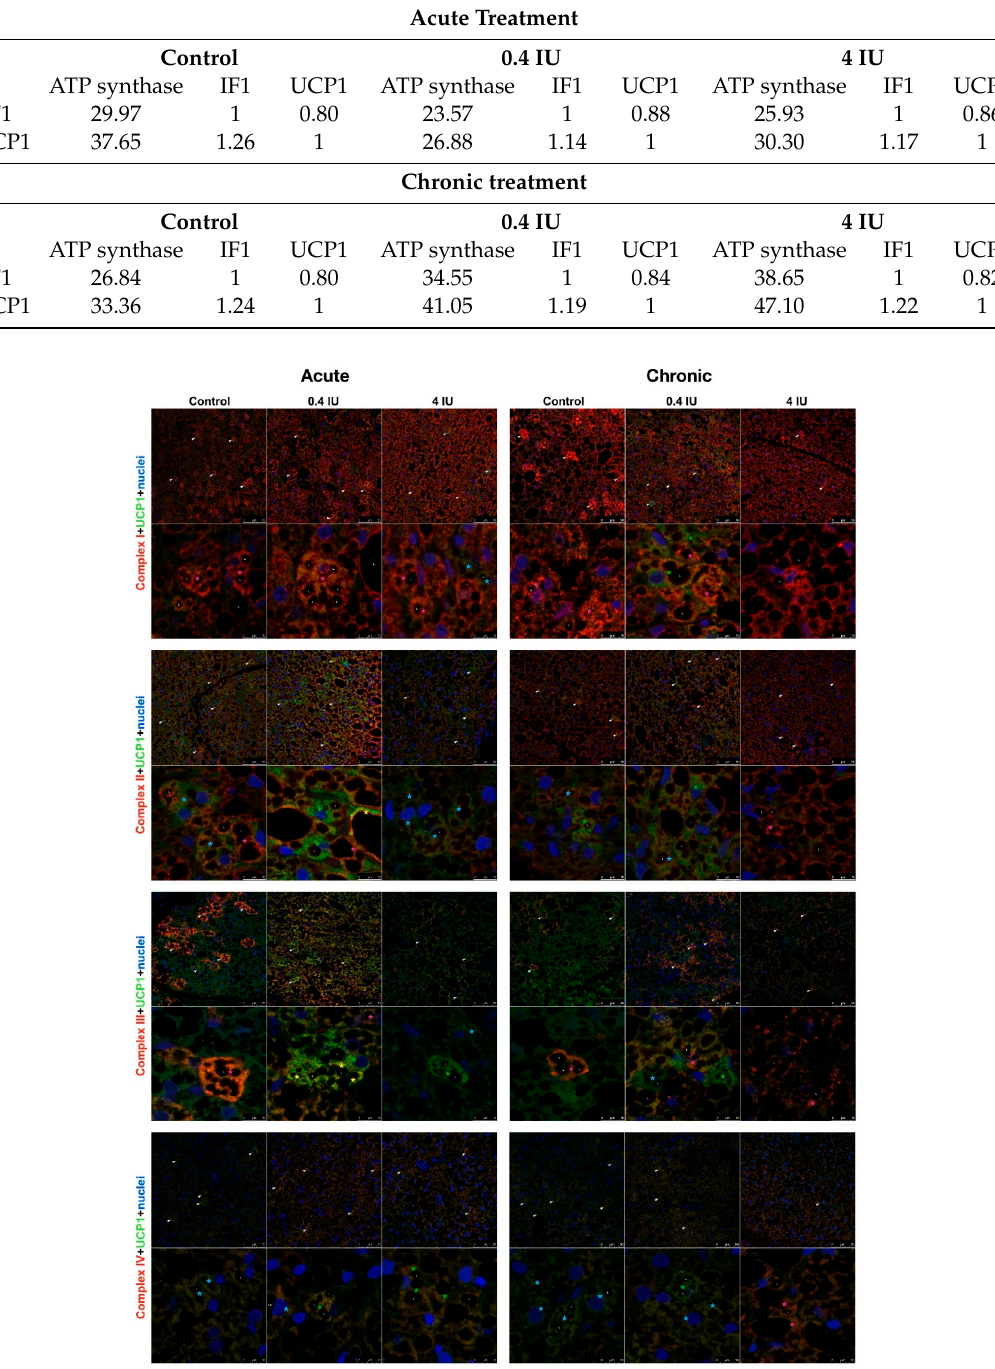
Table 1. Mitochondrial protein stoichiometry following acute and chronic insulin treatment.